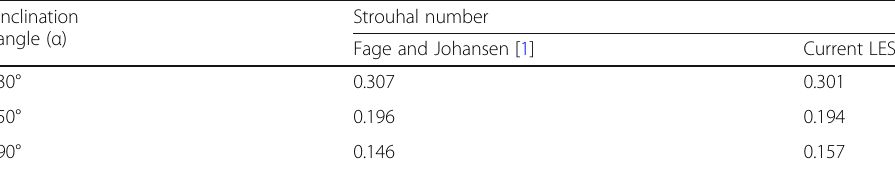
Strouhal number Fage and Johansen